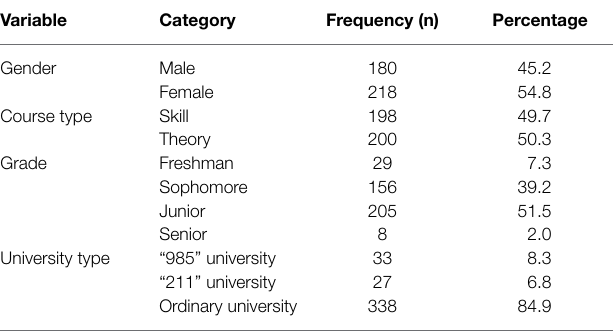
TABLE 1 | Demographic characteristics of the